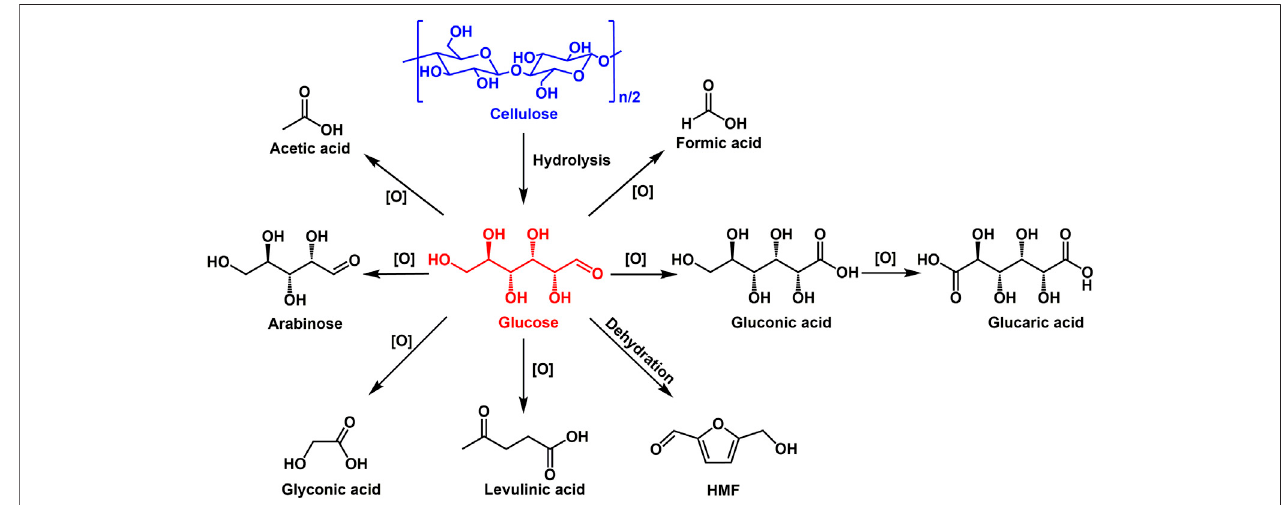
FIGURE 4 | Chemicals produced by oxidation of glucose.